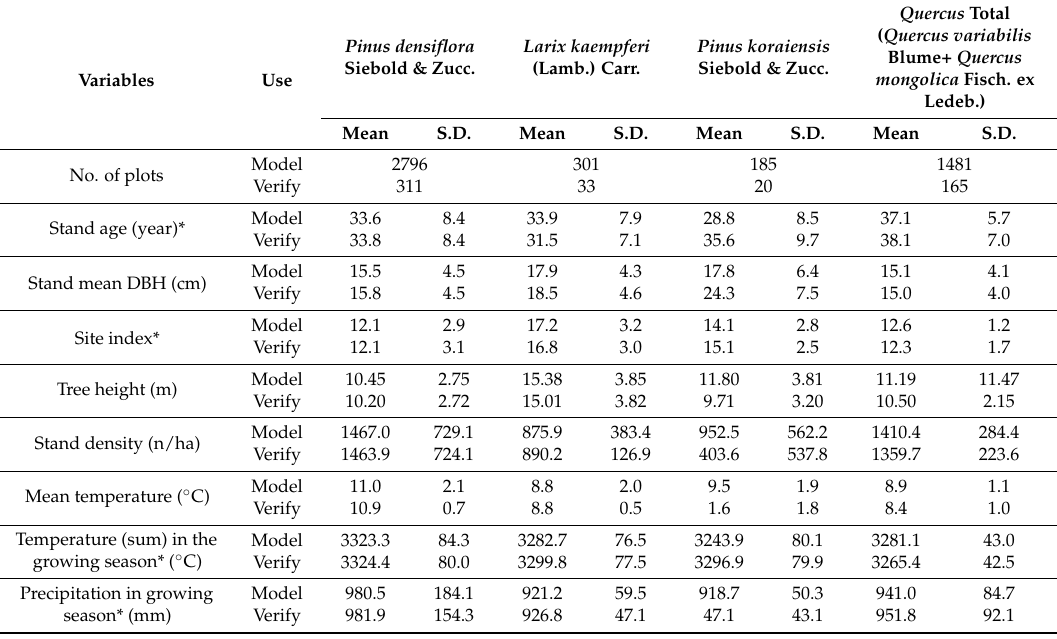
Table 1. General description of variables used in this study from the 5th National Forest Inventory (NFI; 2006–2010) and automated weather station (AWS).